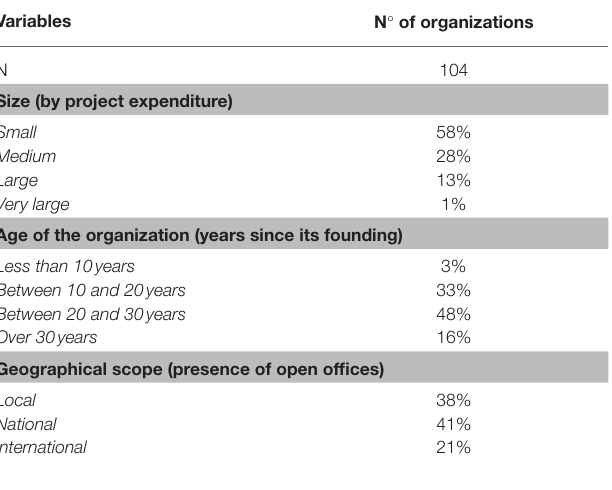
TABLE 4 | Characterization of the